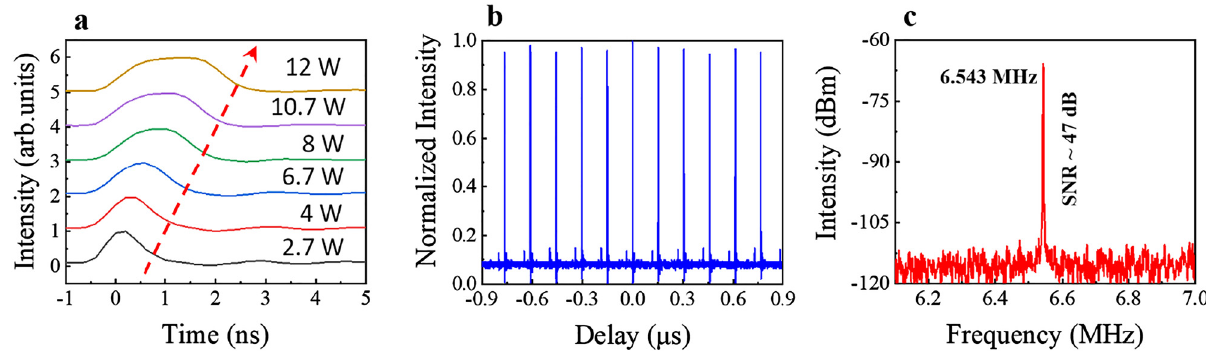
Figure 7: (a) Pulse shape evolution for the pump power of 2.7, 4, 6.7, 8, 10.7, and 12 W. (b) Mode-locking pulsed trace of intra-cavity OVB. (c) The RF spectrum at the fundamental frequency of